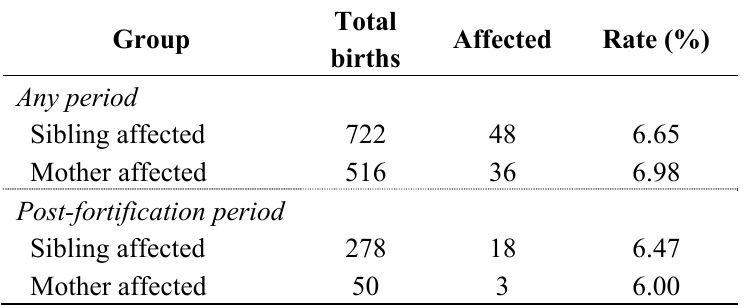
Table 3. Historic recurrence rates in Brazil